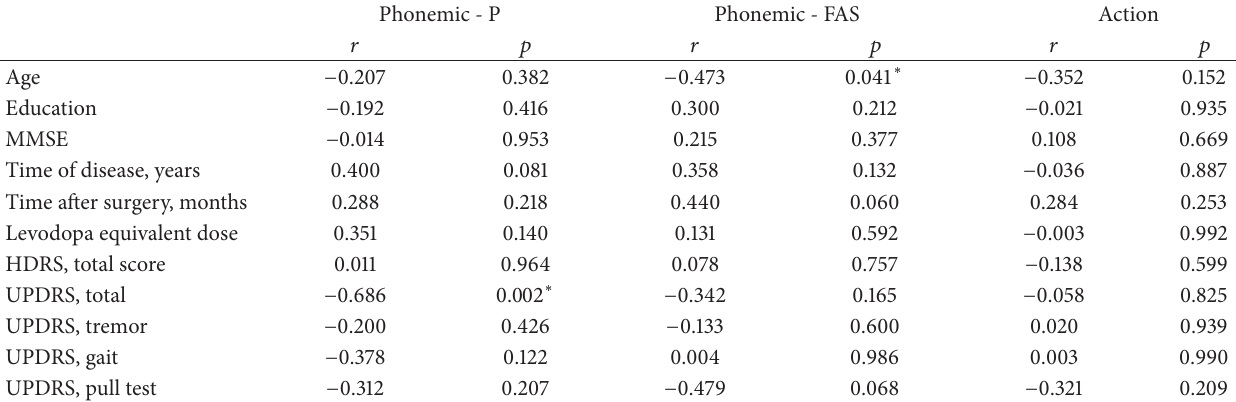
Table 6: Correlational analysis between VF tasks (phonemic and action), demographic, cognitive, and clinical